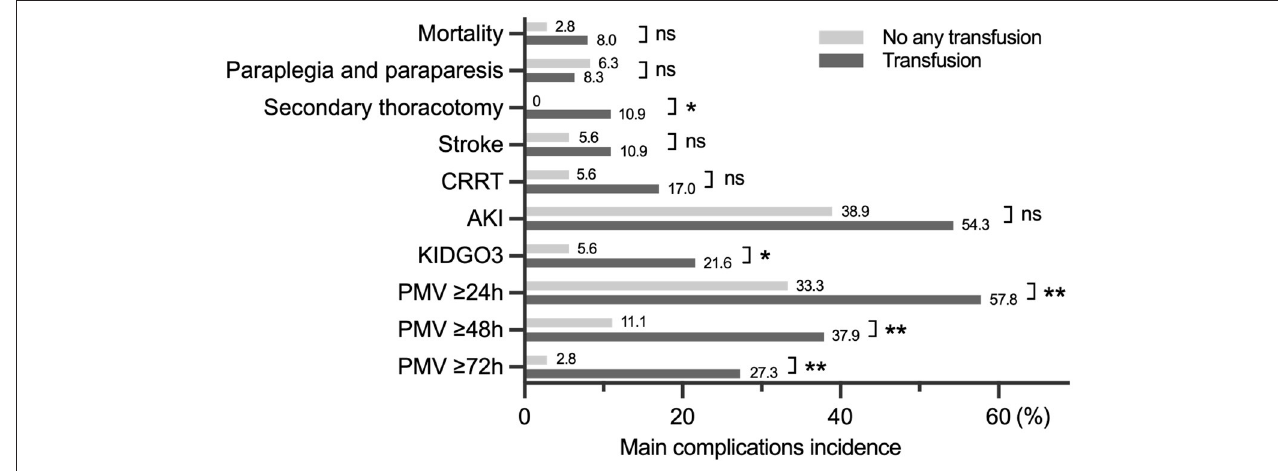
FIGURE 3 | The difference in the incidence of complications between transfusion and no transfusion. CRRT, continuous renal replacement therapy; AKI, acute kidney injury; KDIGO, kidney disease improving global outcomes; PMV, prolonged mechanical ventilation. * p < 0.05, ** p <